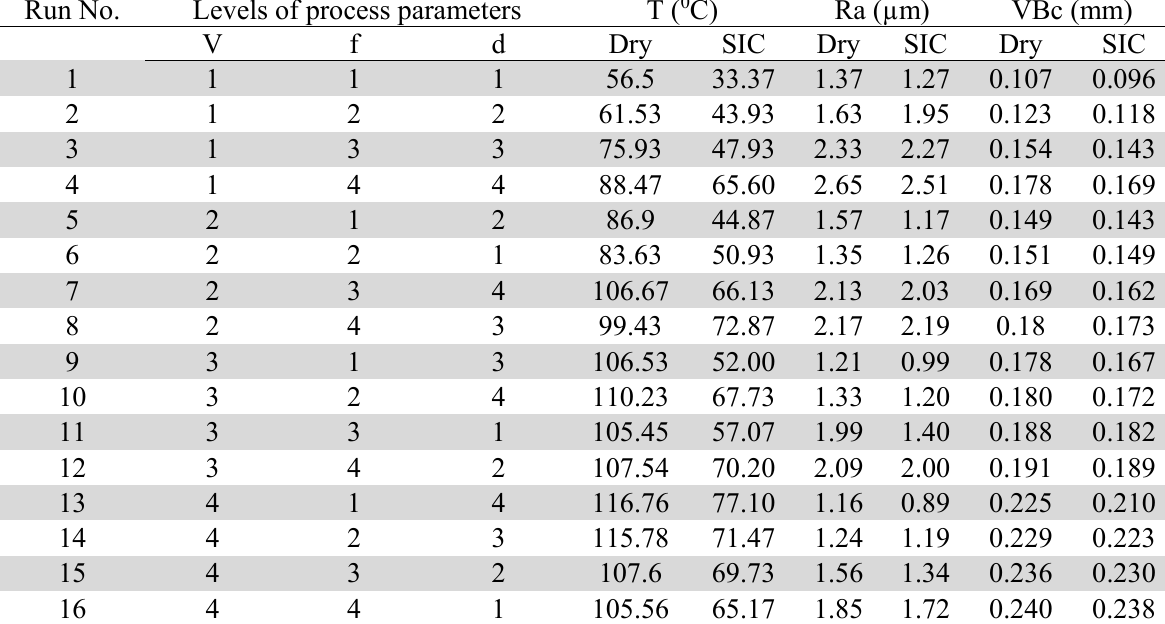
Fig. 8 (a-d) respectively. Optical micrographs of the machined surface (Fig. 9 a-b) reveal that the surface imperfections were due to formation of grooves, particle pull out and particle